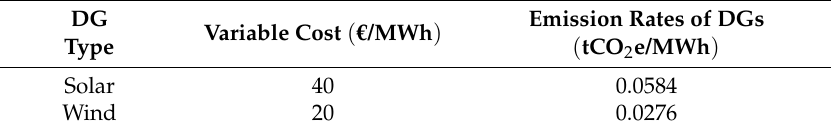
Table 4. The cost of electricity generation from renewable sources and emission